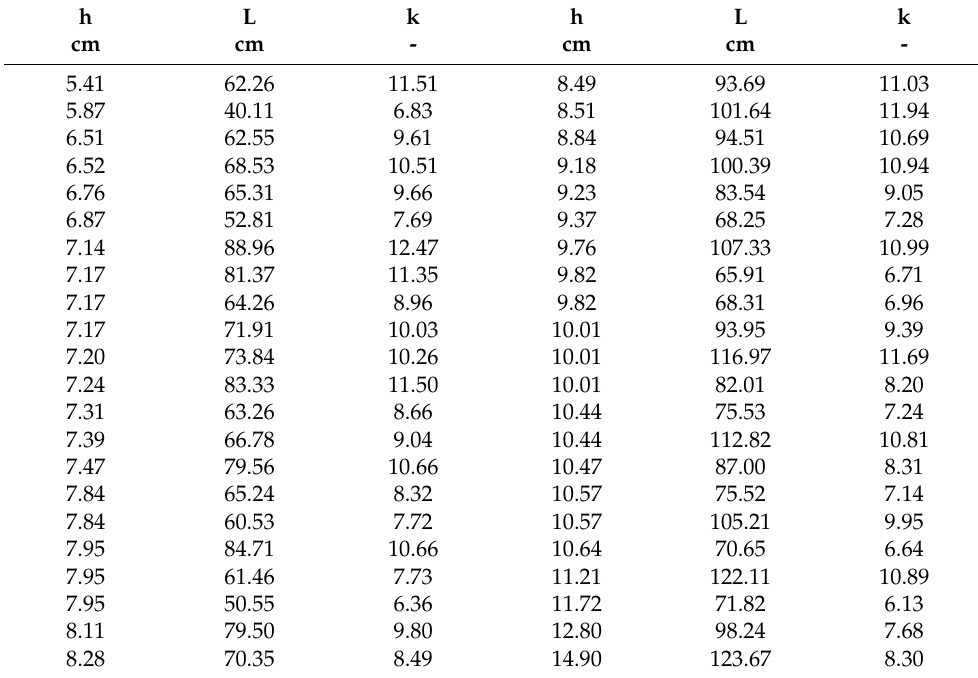
Table 2. The sea ice information measured from conical